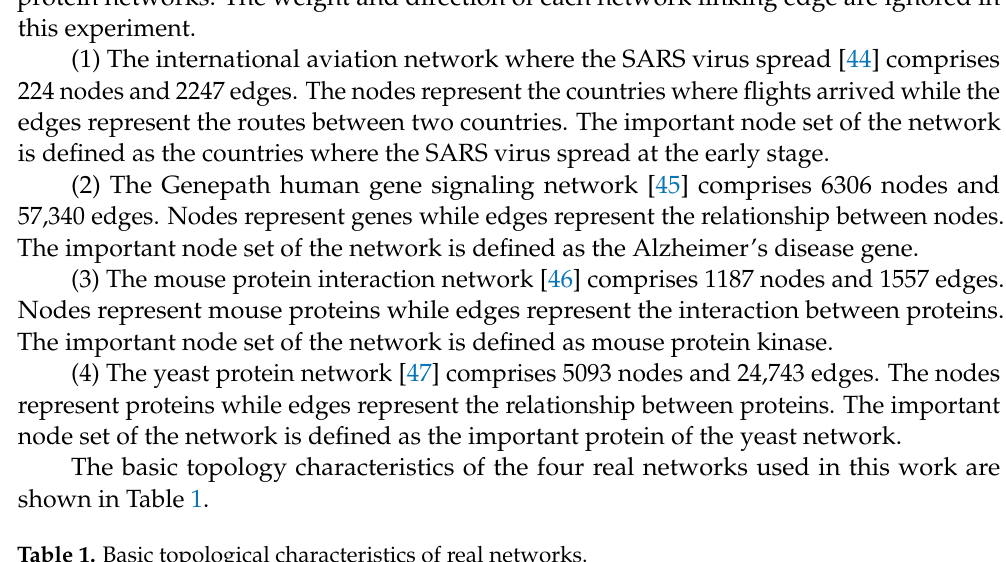
Table 1. Basic topological characteristics of real